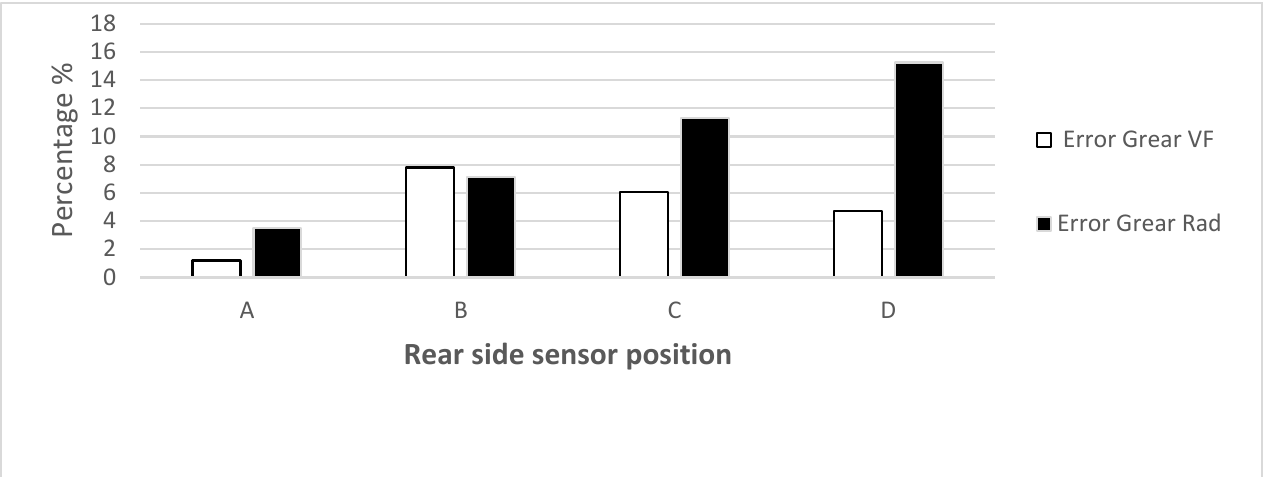
Figure 8. Rear irradiance distribution error for the ray tracing and view factor methods for four positions of measurement (A, B, C, and D).